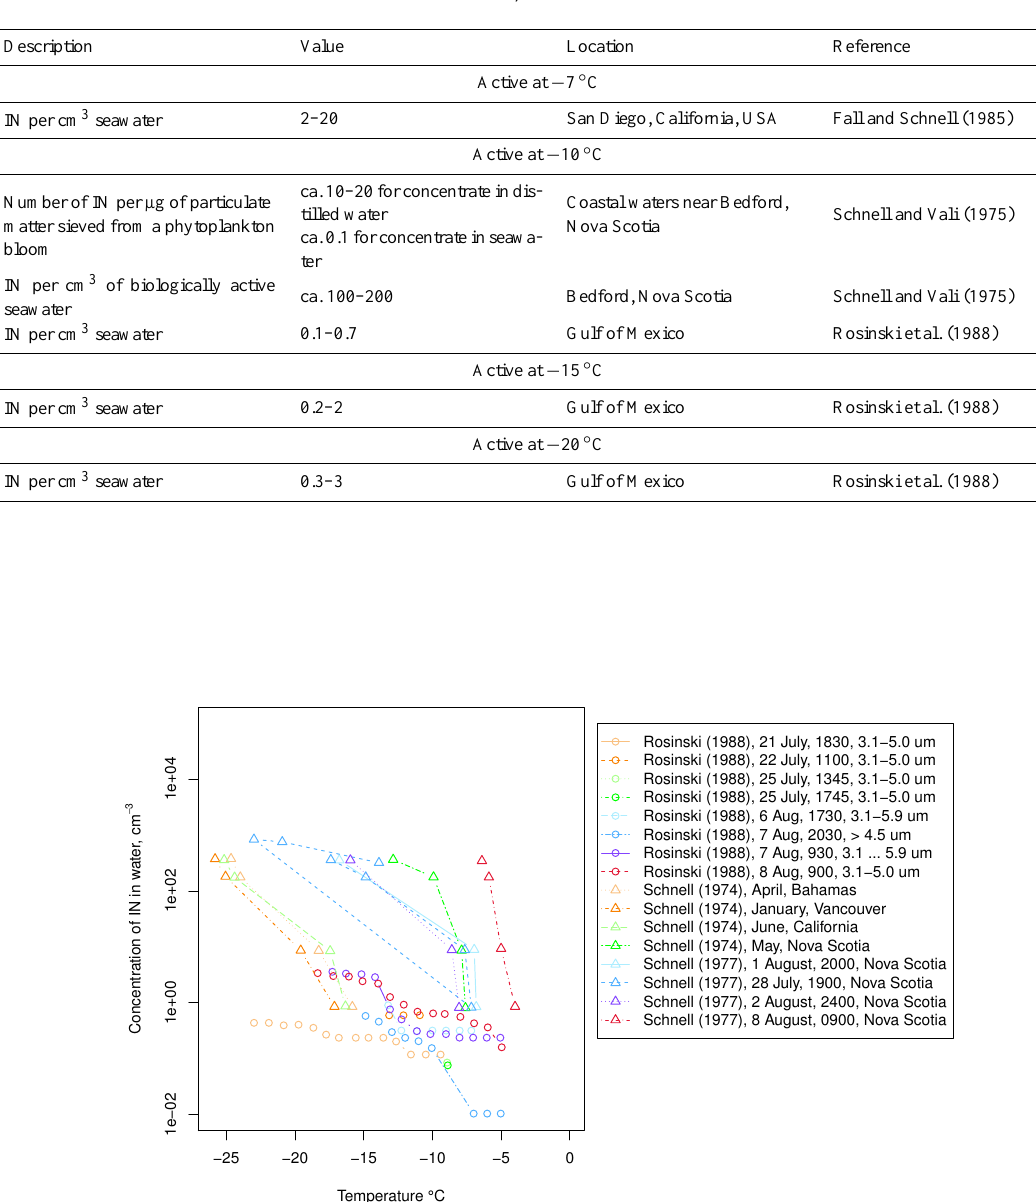
Table A1. Concentrations of IN measured in marine surface waters, selected values.